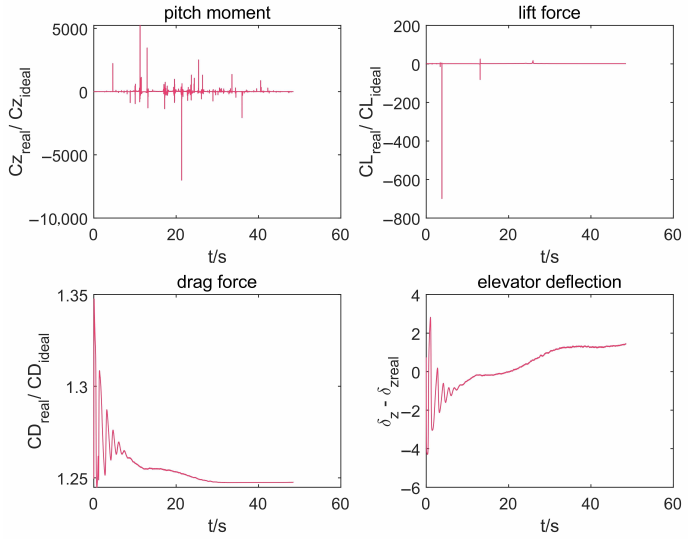
Figure 9. The effect on